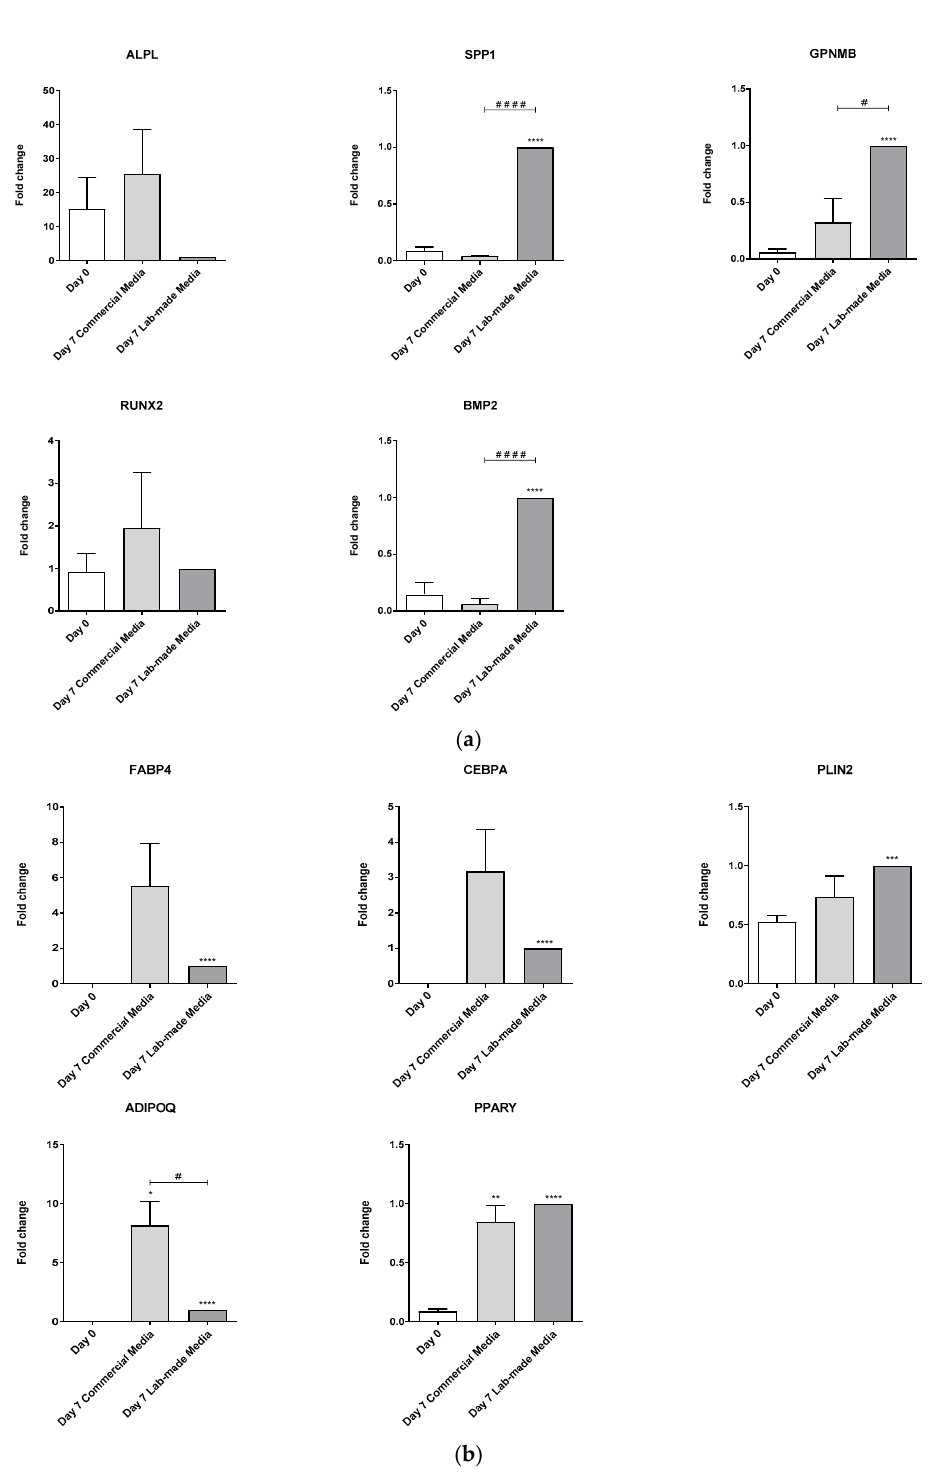
Figure 3. Comparison between commercial and lab-made media adipogenic and osteoblastogenic differentiation induction in primary hMSC. ( a , b ) Differentiation of primary hMSC for 7 days with commercial and lab-made media. FABP4, CEBPA, PLIN2, ADIPOQ, and PPAR γ adipogenic marker gene expression measured by RT-qPCR. Data coming from at least three independent experiments are presented as fold change over lab-made differentiation data and expressed as the Mean ± SEM (* p < 0.05; ** p < 0.01; *** p < 0.001; **** p < 0.00001). Differences between commercial medium and Lab-made medium were indicated as # p < 0.05; #### p <